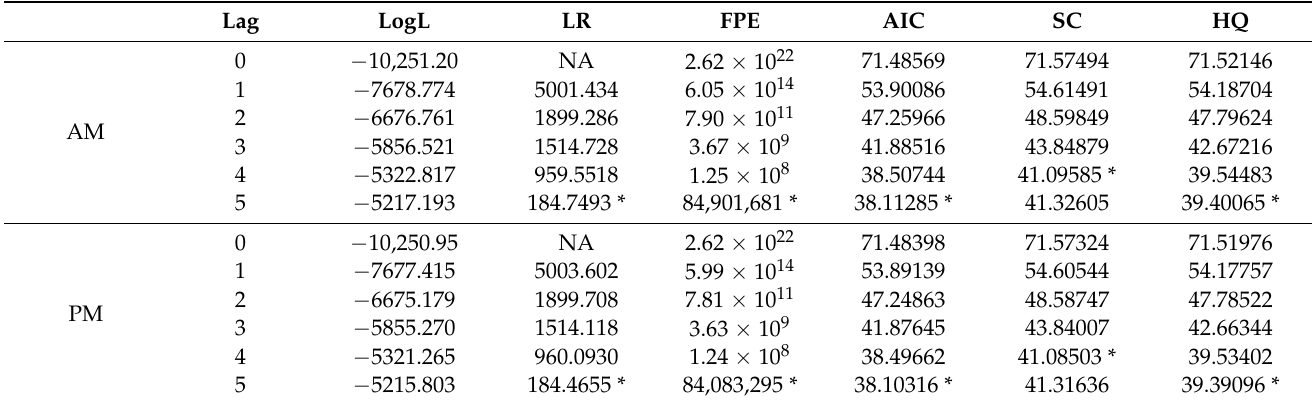
Table 3. Selection of VAR optimum lag length.